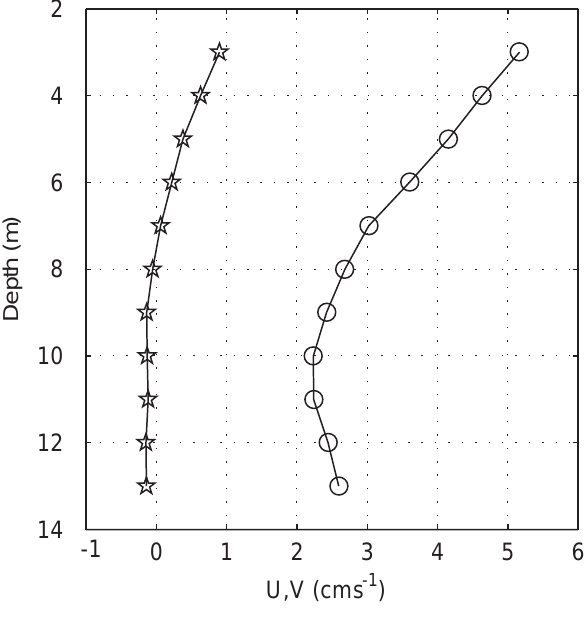
Fig. 7. Mean current components profile, averaged over 57 days measurement